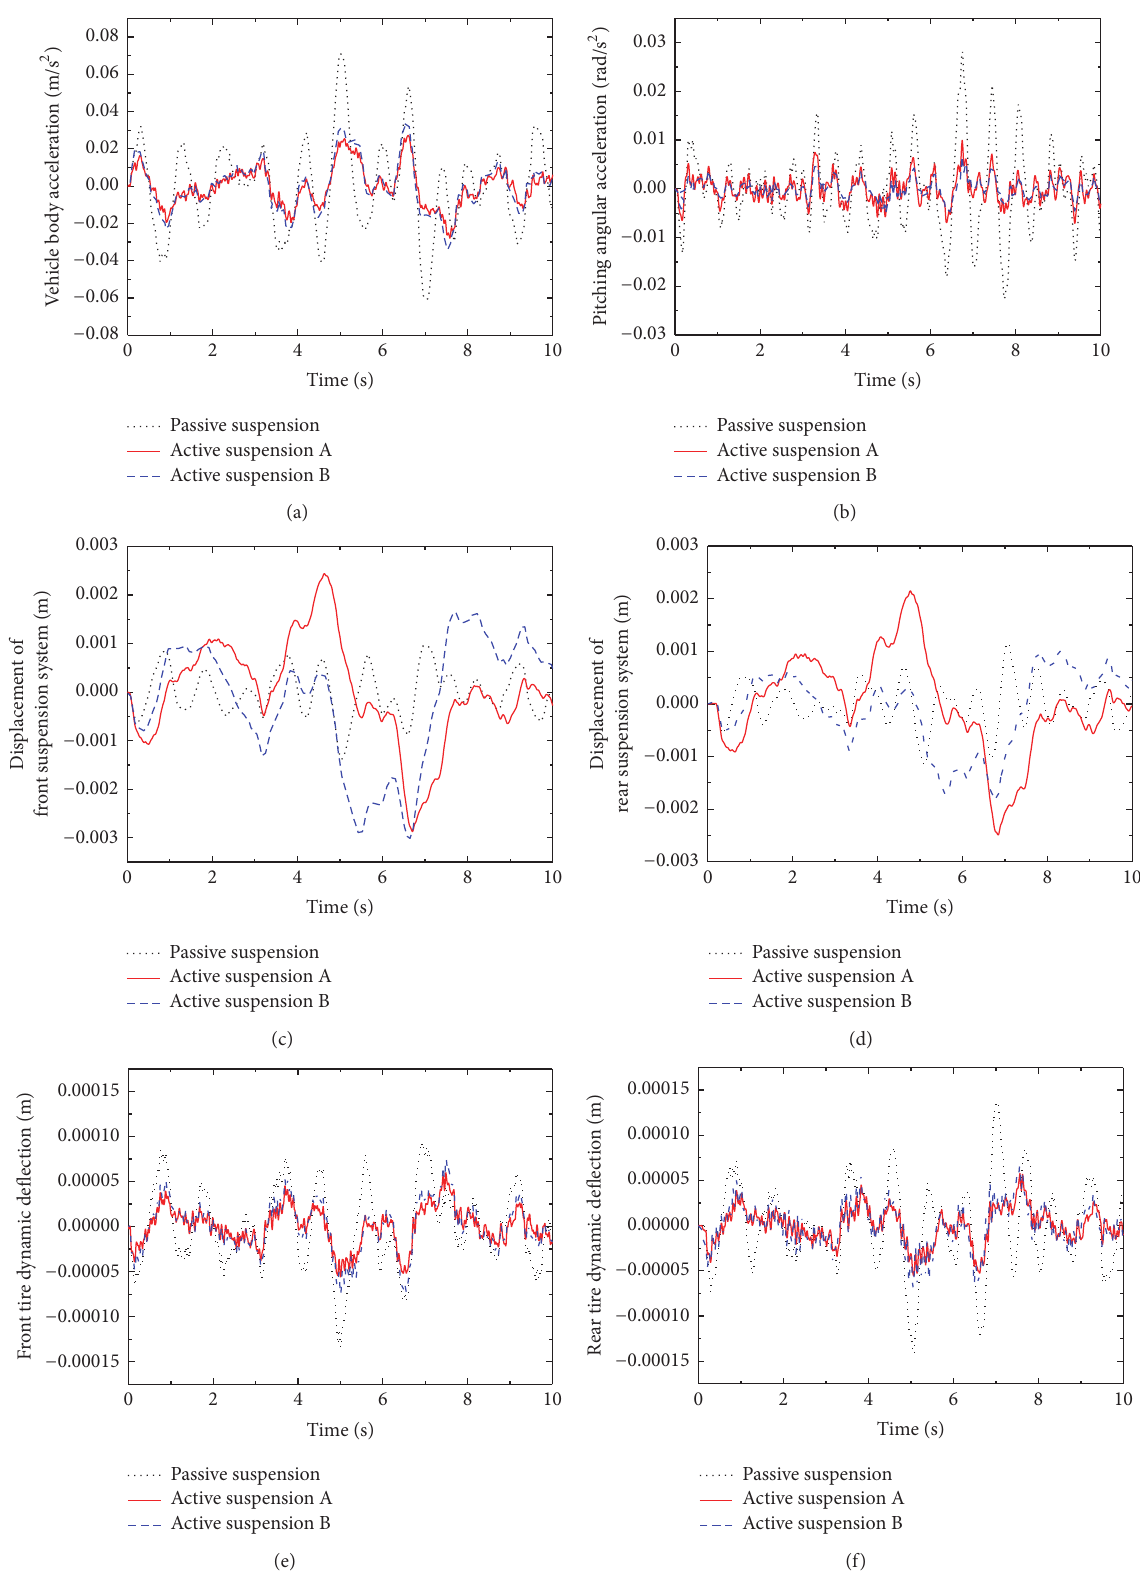
Figure 4: Time responses to passive suspension, active suspension A, and active suspension